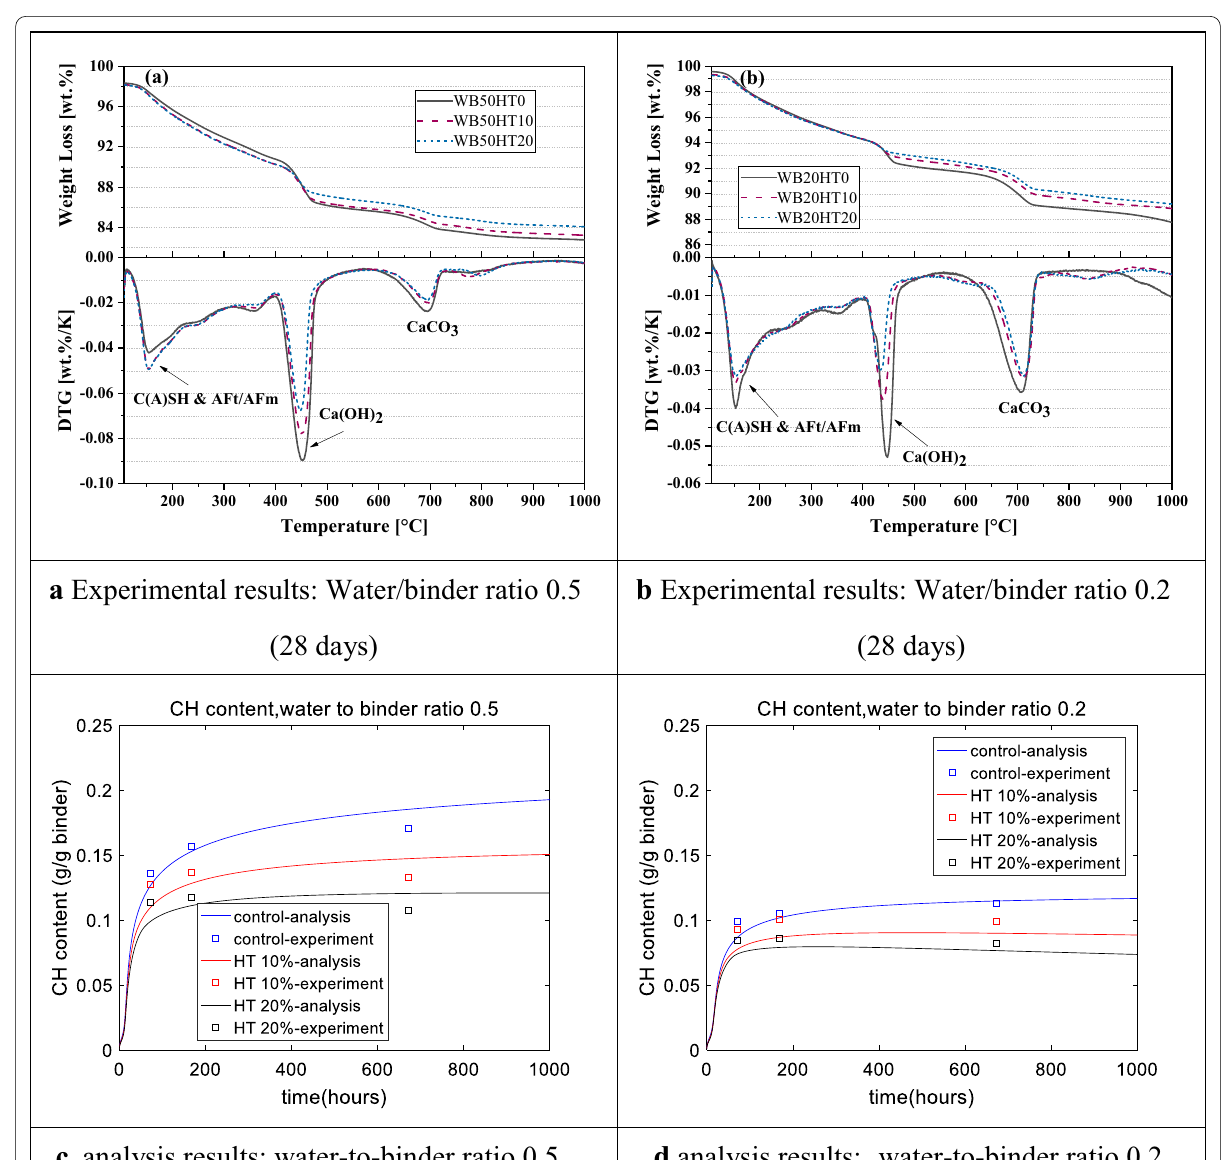
Fig. 3 Calcium hydroxide content in cement–hwangtoh blends (Lin et al. 2019).